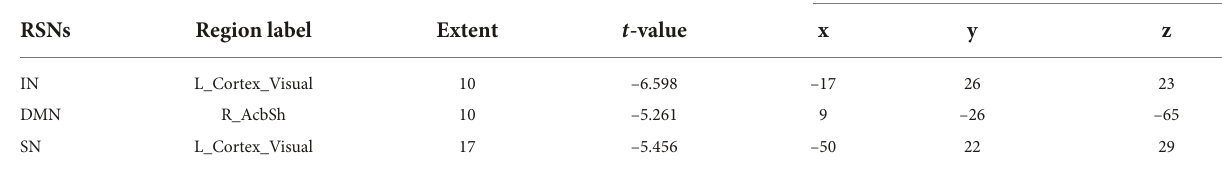
TABLE 1 Differences between MCAO/R and sham groups in resting state functional connectivity of